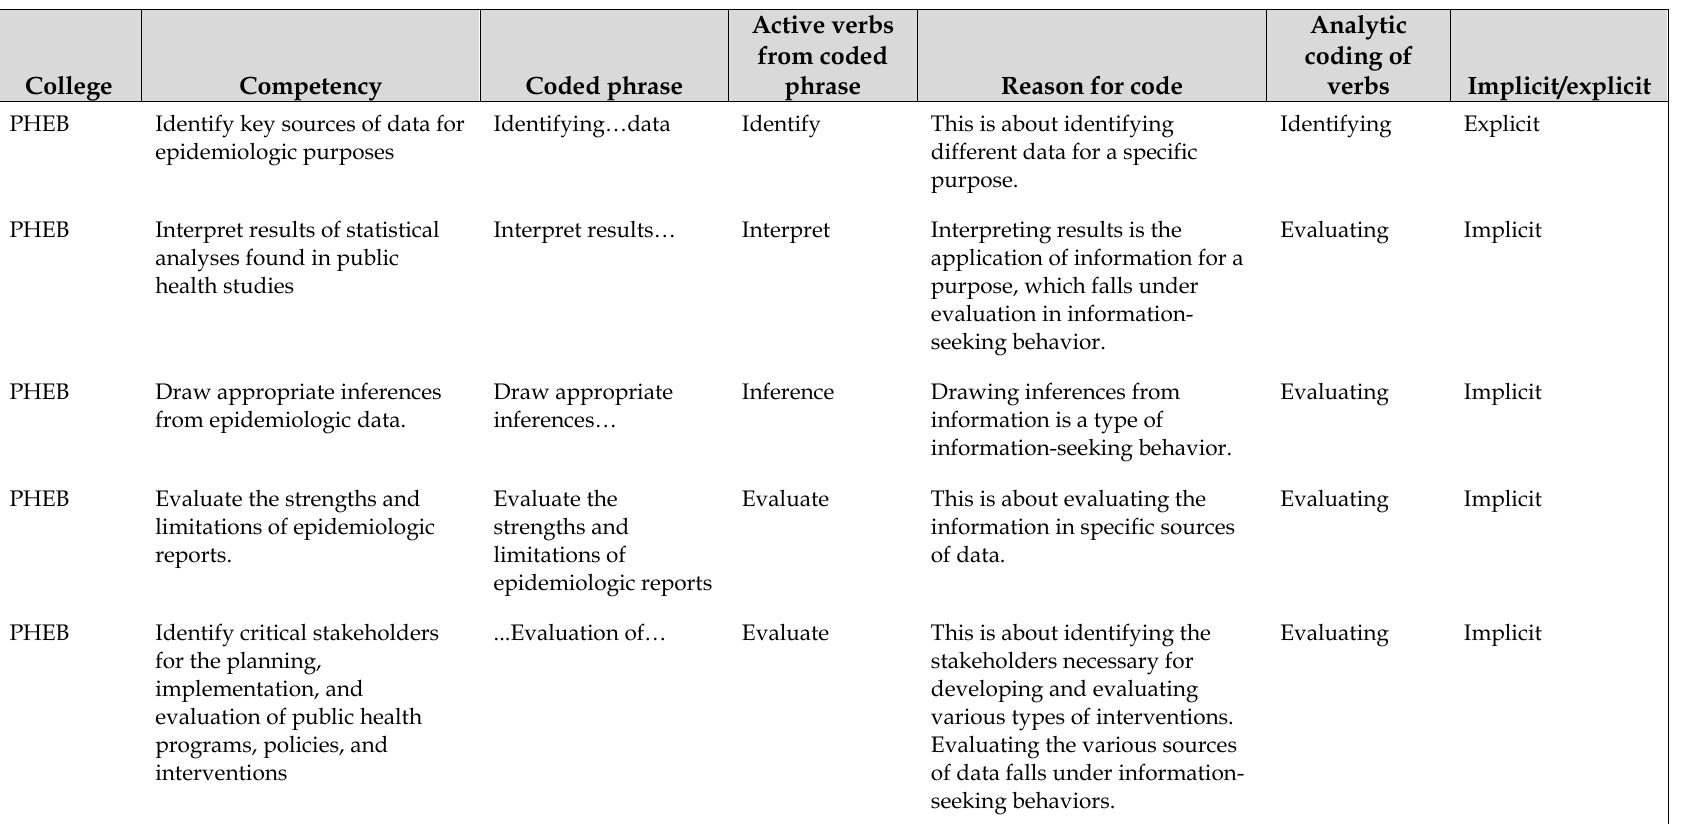
Table 2 Competencies with implicit or explicit information skills and behaviors